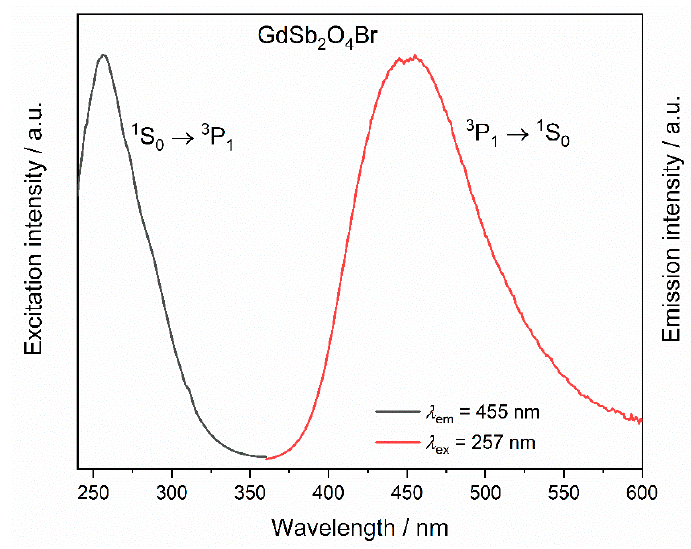
Figure 10. Excitation ( λ em = 455 nm) and emission spectra ( λ ex = 257 nm) of GdSb 2 O 4 Br. Upon excitation into 257 nm, a broad band is visible in the emission spectrum in the region between 400 and 500 nm (Figure 10), with a maximum at 455 nm, corresponding to the transition 3 P 1 → 1 S 0 . This band in the blue region of the electromagnetic spectrum occurs for all the investigated compounds upon excitation in 1 S 0 → 3 P 1 (inset in Figure 11, left). For TbSb 2 O 4 Br:Eu 3+ and GdSb 2 O 4 Br:Eu 3+ its intensity is negligible compared to the Eu 3+ transitions (Figure 11, left) and less intense than Tb 3+ transitions in the terbium derivatives (inset in Figure 11, left), suggesting the presence of an energy transfer (ET) from Sb 3+ to Ln 3+ . The different contribution of the Sb 3+ emission (blue region) compared to the Eu 3+ emission (red region) as well as Tb 3+ role, are demonstrated by the chromaticity coordinates calculated for TbSb 2 O 4 Br:Eu 3+ and GdSb 2 O 4 Br:Eu 3+ ( λ ex = 257 nm) (Figure 11, right ). In order to explain this difference, a deep investigation on the luminescence properties of both TbSb 2 O 4 Br:Eu 3+ and GdSb 2 O 4 Br:Eu 3+ was performed.